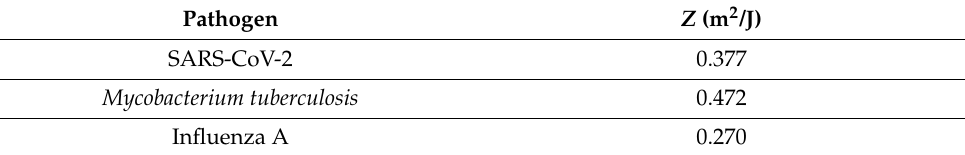
Table 1. Inactivation constants Z in aerosol